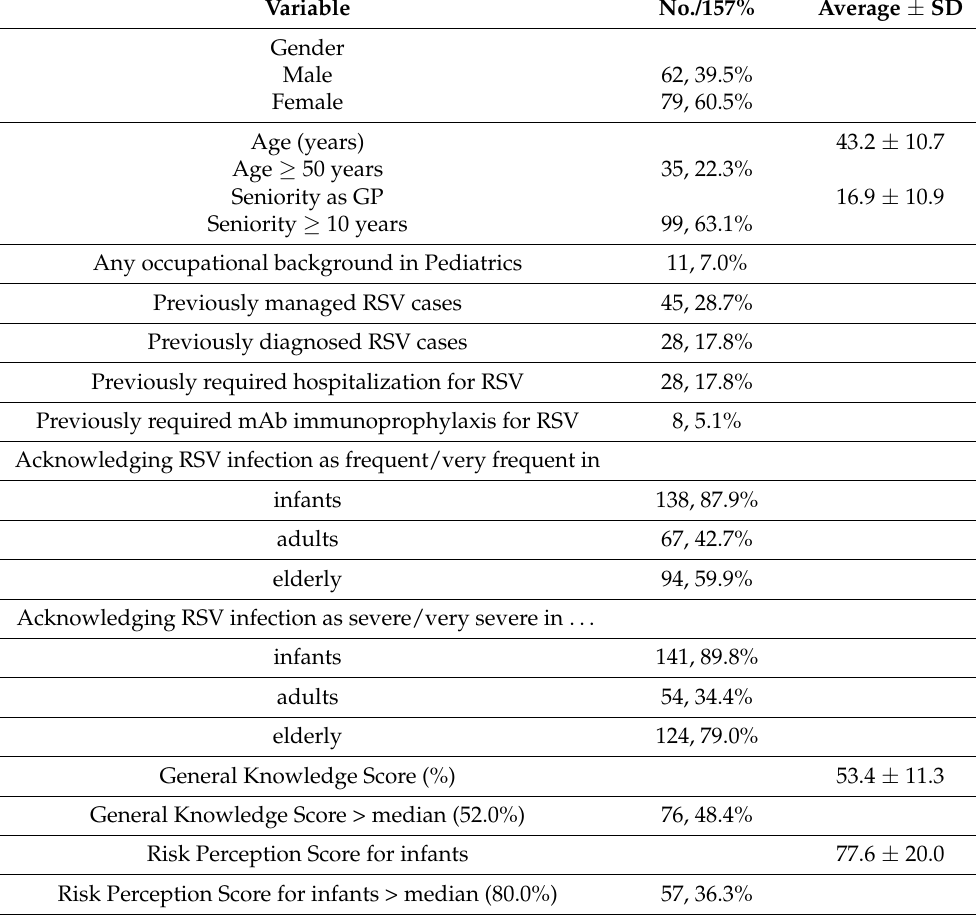
Table 1. Characteristics of the 157 Italian general practitioners (GPs) participating in the survey on knowledge, attitudes and practices for respiratory syncytial virus (Note: SD = Standard